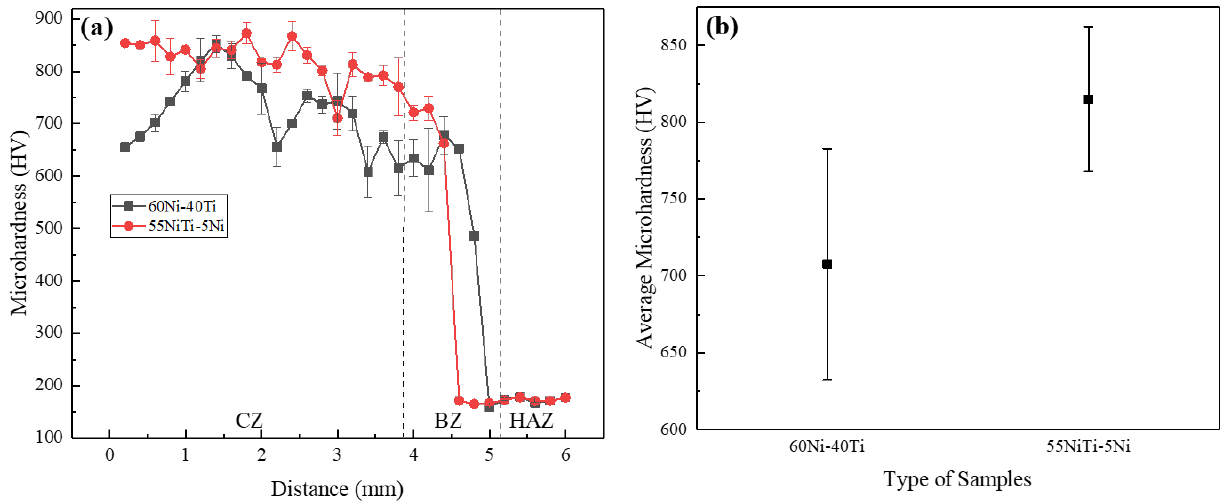
Figure 8. Microhardness development by depth ( a ) and average microhardness in cladding zone ( b ) of coatings.